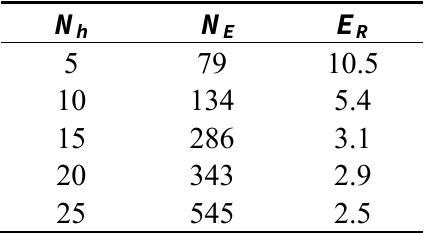
) ensuring the convergence of the training algorithm E ) at the final epoch for different numbers R ). The NN designed for L-band,  = 34° ( i.e. , N = 3), with one h i i